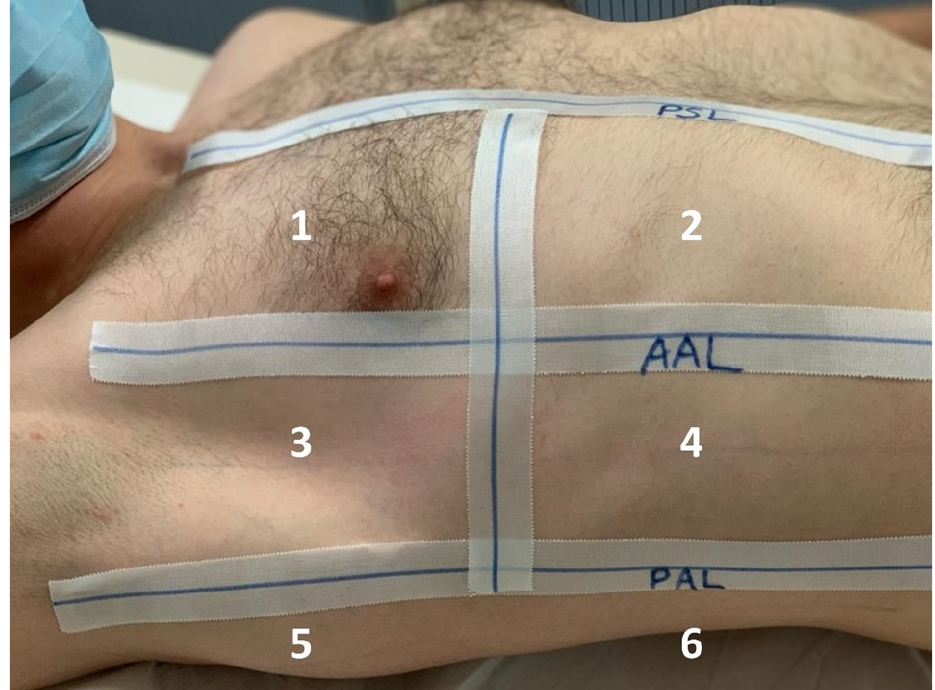
Figure 1. Lung areas for the right lung (labeled 1–6), PSL = parasternal line; AAL/PAL = ante- rior/posterior axillary line.